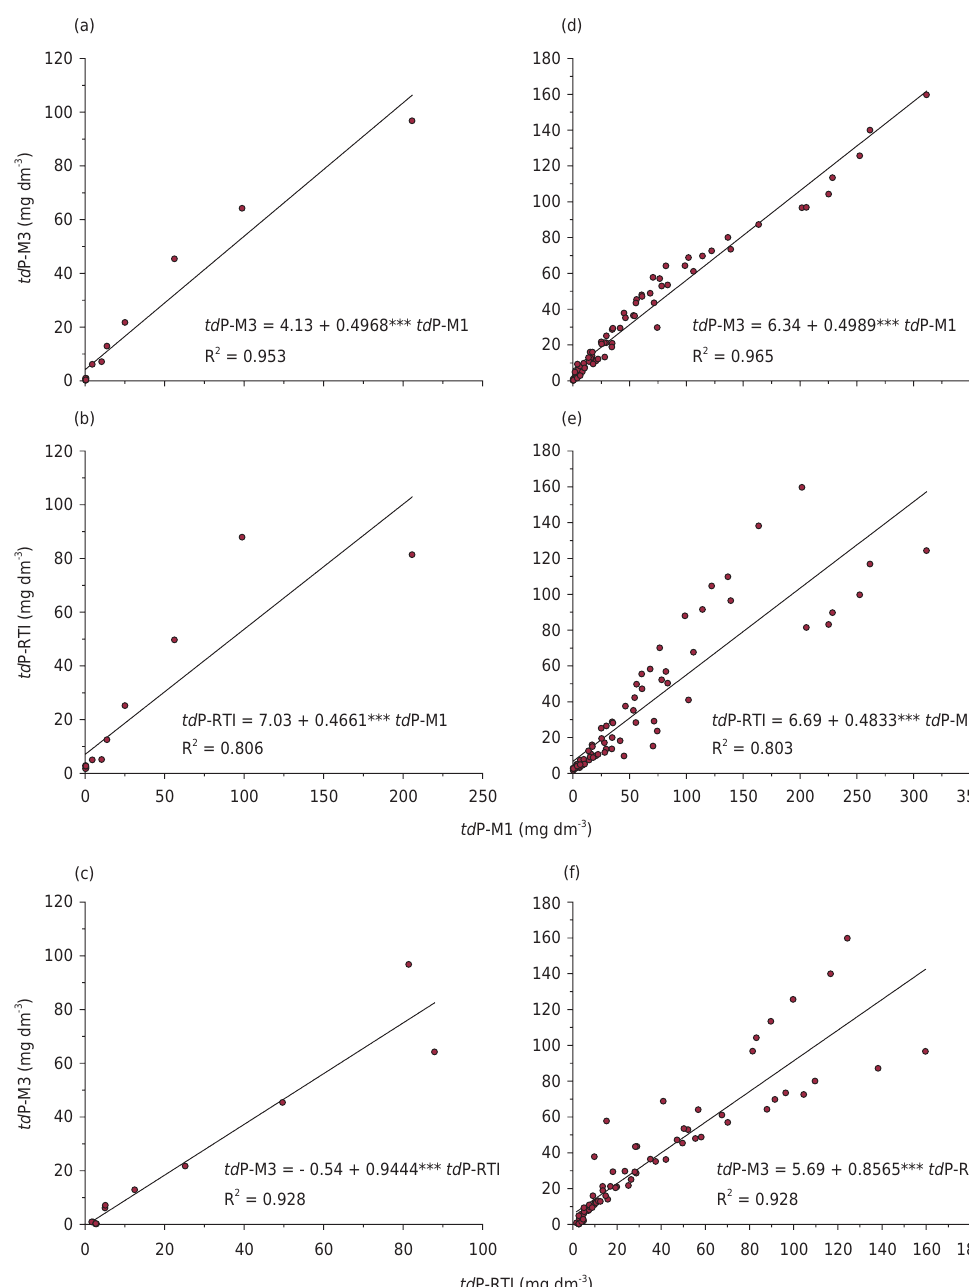
Figure 4. Correlation between soil available P content by Mehlich-1 (P-M1), Mehlich-3 (P-M3), and Ion Exchange Resins (P-IER) in 12 soils cultivated with corn. Correlation performed with the available P contents of the controls (no P application) (a, b, and c), and correlation with the available P contents of all the experimental units (d, e, and f). *** significant at 0.1